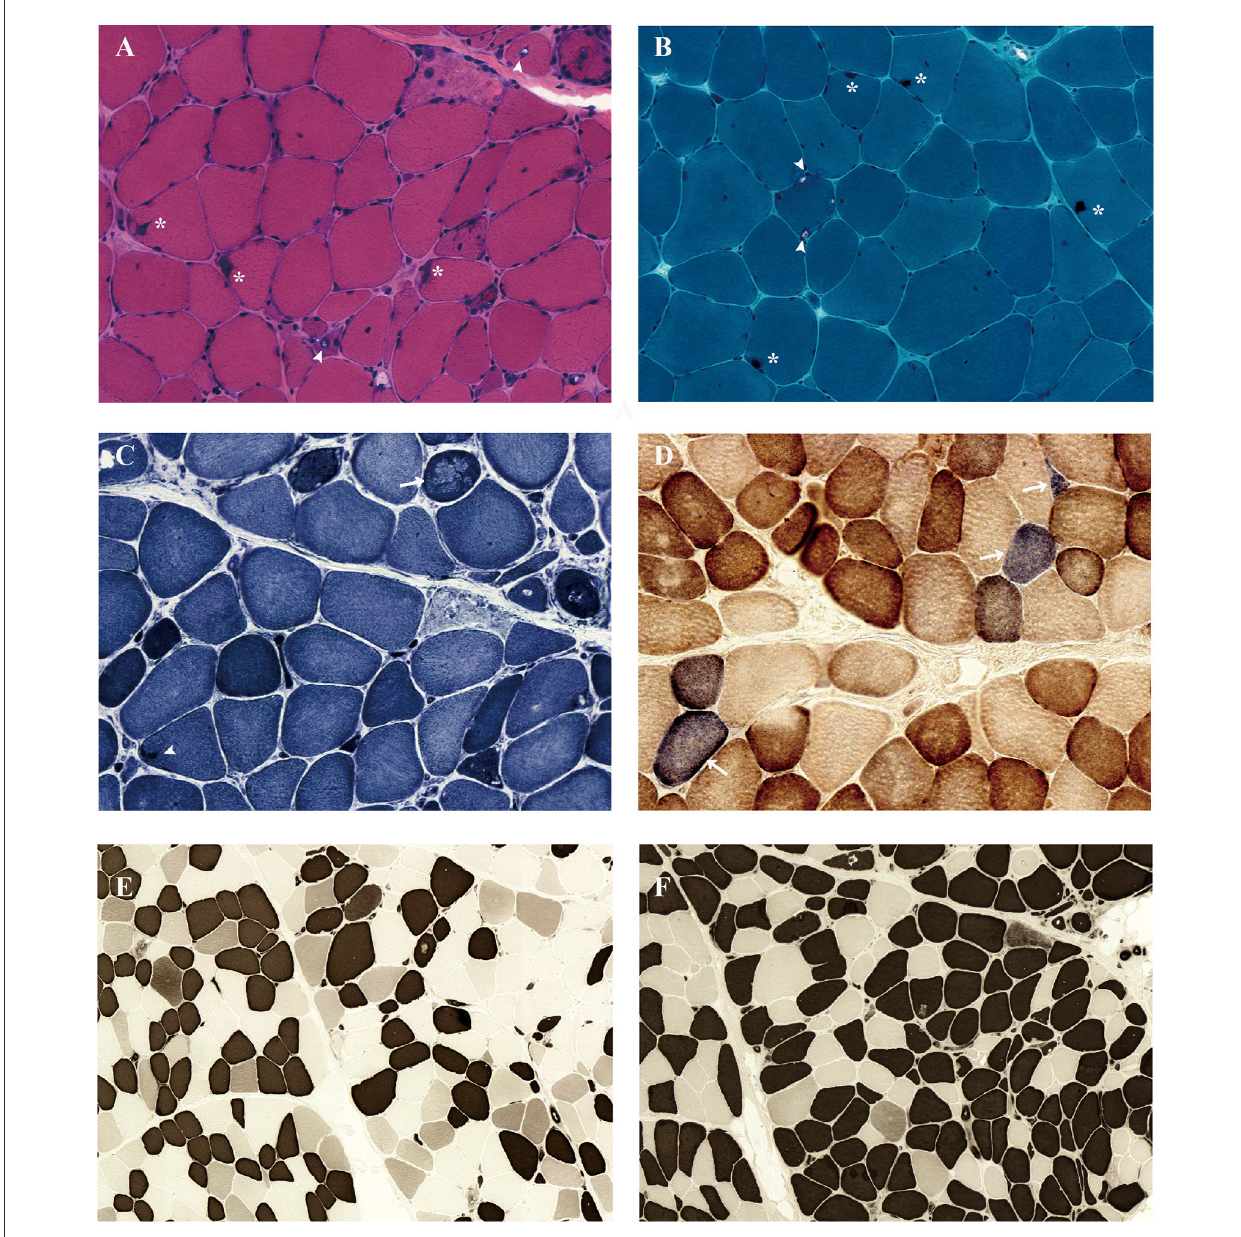
FIGURE2 Muscle biopsy of the biceps brachii muscle demonstrated a rimmed vacuolar myopathy. Light microscopy of muscle biopsy shows size variability, excess internal nuclei, necrotizing fiber, degenerating fibers, basophilic deposition (*), and rimmed vacuoles (arrowhead) under hematoxylin and eosin staining (A) . Gomori trichrome staining revealed rimmed vacuoles (arrowhead) and darkly stained materials (*) (B) . Nicotinamide adenine dinucleotide dehydrogenase–tetrazolium reductase staining revealed decreased oxidative enzyme reactivity (arrow) and darkly stained materials (arrowhead) in some myofibers (C) . Combined cytochrome c oxidase (COX)/succinate dehydrogenase (SDH) stain demonstrates several COX-negative fibers (arrows) (D) . The fibers show the checkerboard-like distribution in ATPase 4.5 (E) and ATPase 9.4 stain (F) .